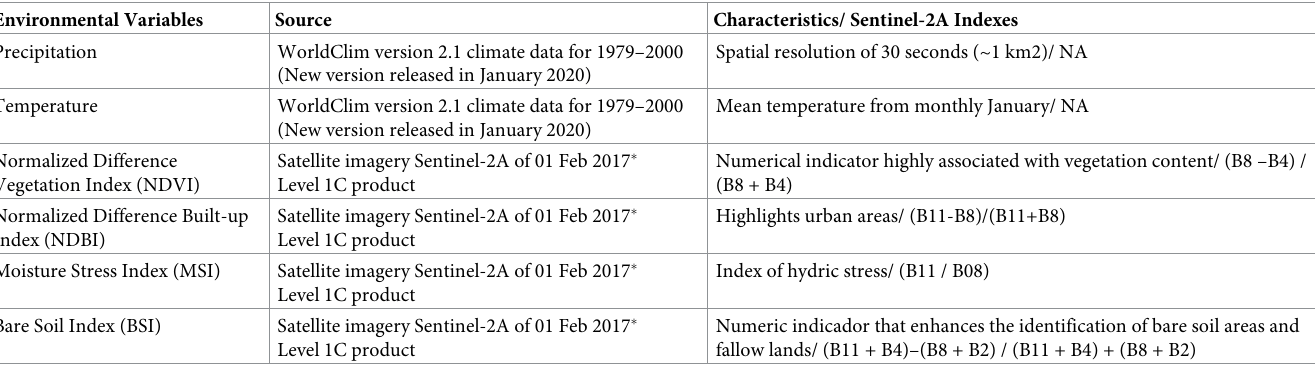
Table 1. Environmental variables used with their characteristics, sources and indexes used to calculate them. Environmental